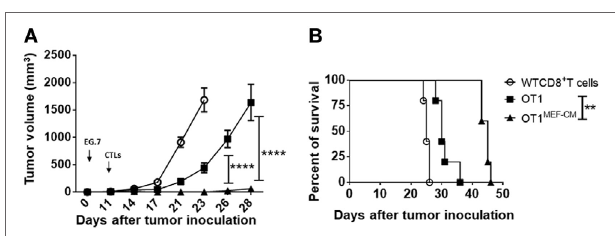
FigUre 7 | Potent in vivo antitumor immunity of mouse embryonic fibroblast-conditioned medium (MEF-CM)-educated cytotoxic T lymphocytes (CTLs). (a,B) EG.7 tumor cells were subcutaneously inoculated in B6 WT mice. After 10–11 days, tumors were detectable. Adoptive transferred CD8 + T cells which were generated in the presence or absence of MEF-CM (50%, v/v). Tumor size and survival were monitored regularly. Serial tumor measurements were obtained. One representative experiment of three with n = 6 mice per group. Comparison of tumor size by two-way ANOVA with Bonferroni’s multiple comparison test. Comparison of survival curves with Log-rank (Mantel–Cox) test (** P ≤ 0.01; **** P ≤ 0.0001).